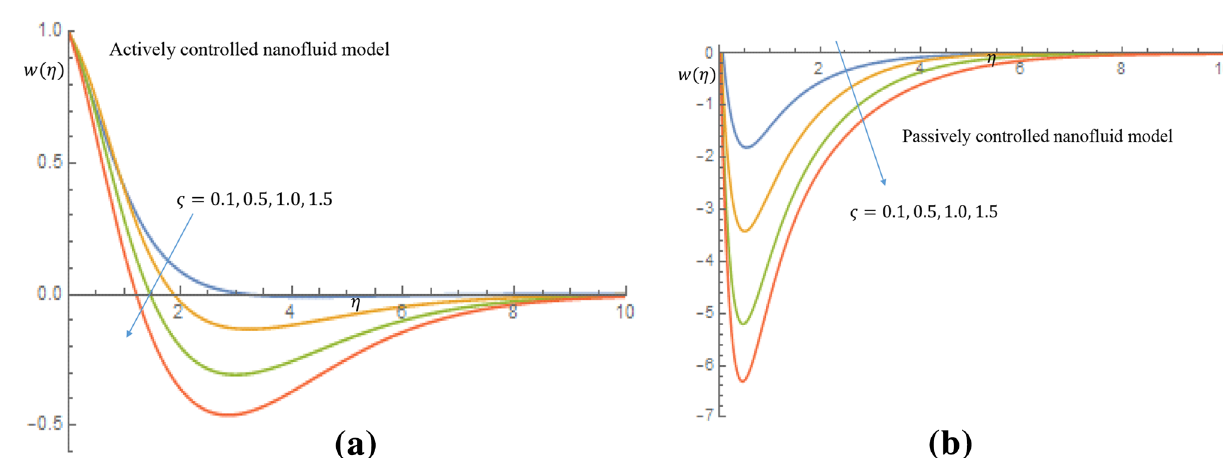
Figure 15. ( a ) Effect of ς on density of motile microorganisms profile when P e = 2.0 . ( b ) Effect of ς on density of motile microorganisms profile when P e = 2.0